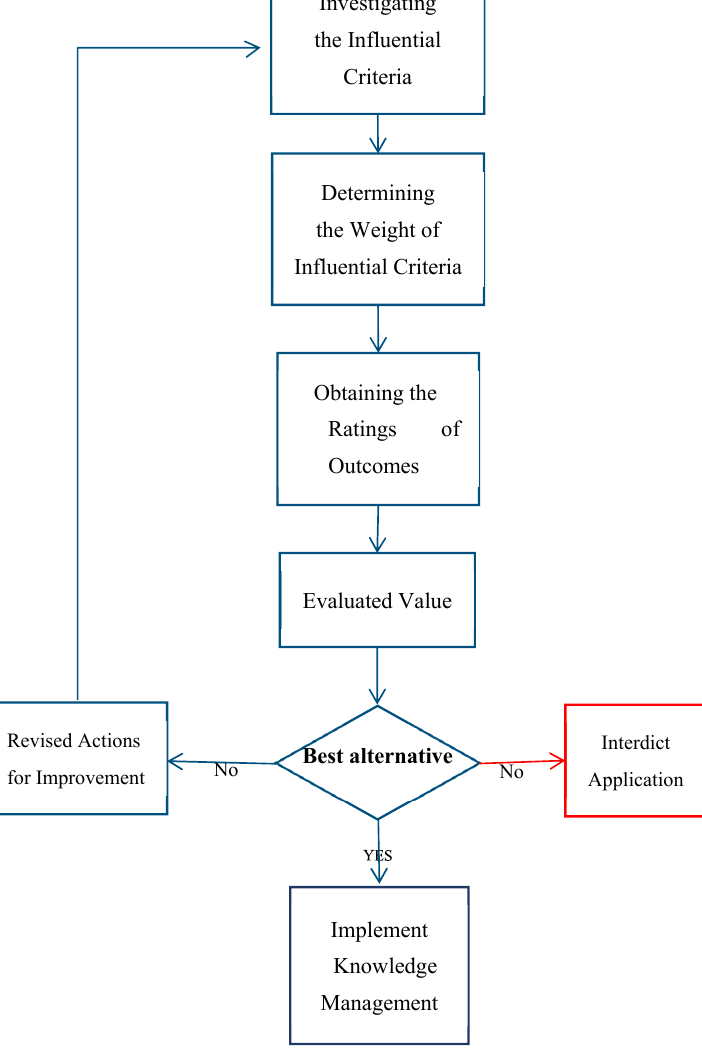
Figure 1. The framework of knowledge management research. Source: Hsieh et al. (2020).